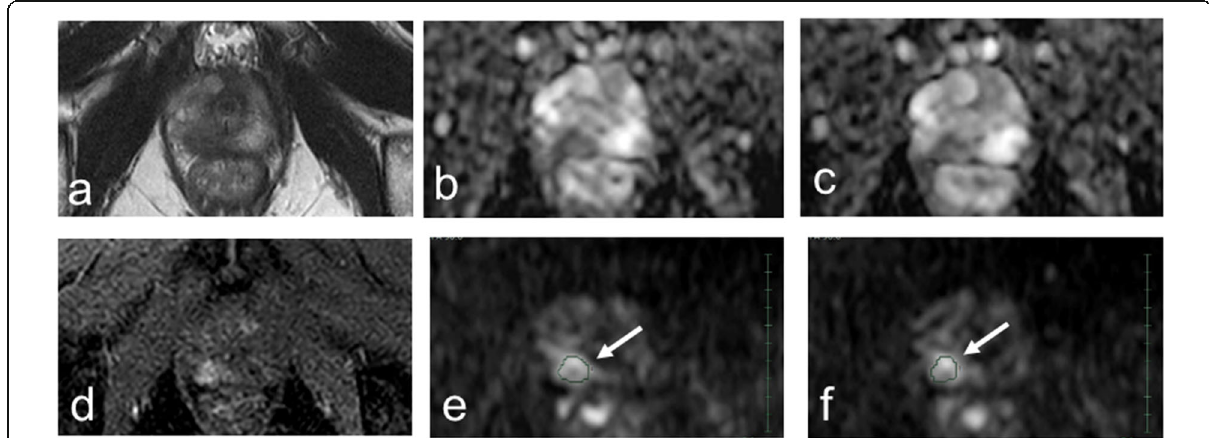
Fig. 2 Multiparametric magnetic resonance imaging of the case (70 years, right peripheral zone cancer, GG of 3, PI-RADS of 4, T2aN0M0). a Axial T2-weighted image (repetition time of 4,000 ms and echo time of 80 ms). b First axial apparent diffusion coefficient (ADC) map (100, 1,000). c